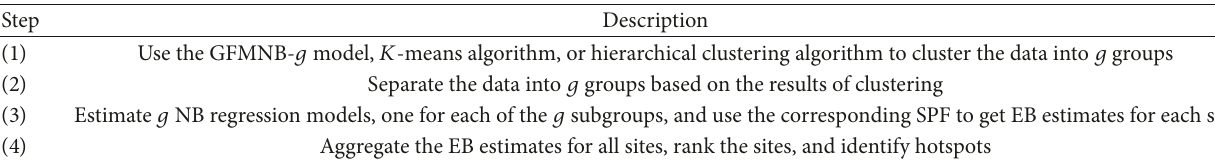
Table 1: Classification-based EB method for HSID.